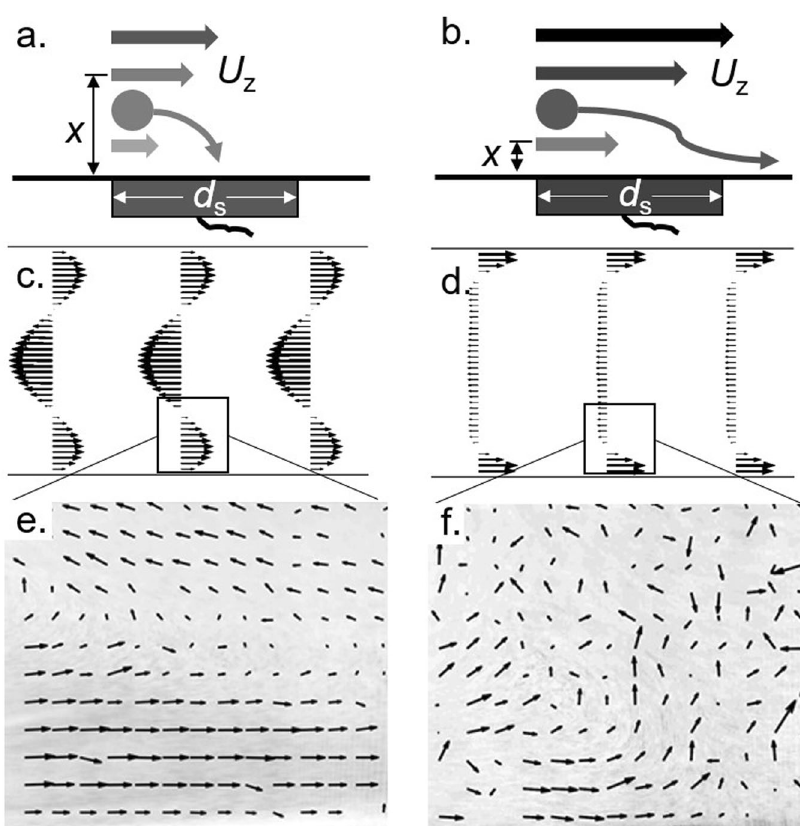
Fig. 5 Flows created by snif fi ng. a – b Illustrations showing a particle in low Womersley fl ow ( a ) has a better chance to strike the sensor surface than in high Womersley fl ow ( b ). U z is the axial velocity, x is the diffusion distance, and d s is the sensor diameter. c – d Simulated fl ow pro fi le at transition from inhalation to exhalation for Wo = 1.5 and Wo = 7.5, respectively. e – f Particle image velocimetry of fl ow pro fi le at transition from inhalation to exhalation for low and high Wo